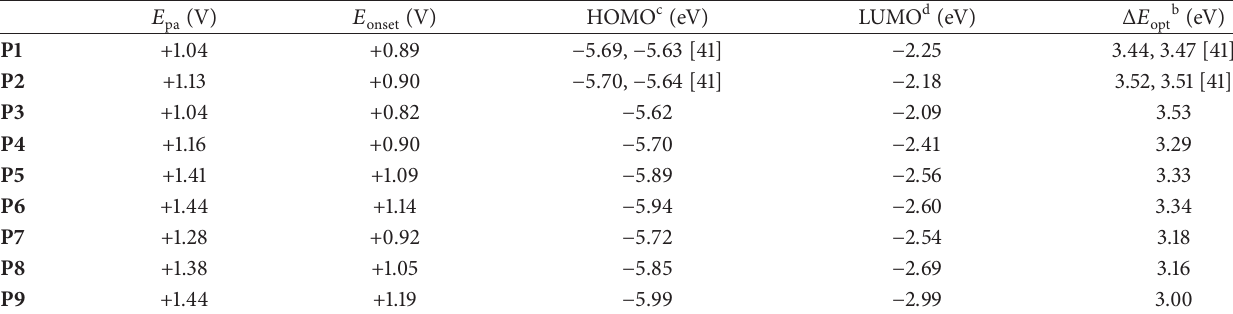
Figure 2: Electronic absorption spectra of (a) P1 , P4 , and P7 ; (b) P2 , P5 , and P8; and (c) P3 , P6 , and P9 recorded in DMF at 30 ∘ C. Table 2: Oxidation potential ( 𝐸 ) and onset ( 𝐸 ) by cyclic voltammetry in DMF (0.05mol L −1 n-Bu 4 NPF 6 ) a , and optical HOMO-LUMO pa onset ) b gaps ( Δ𝐸 opt